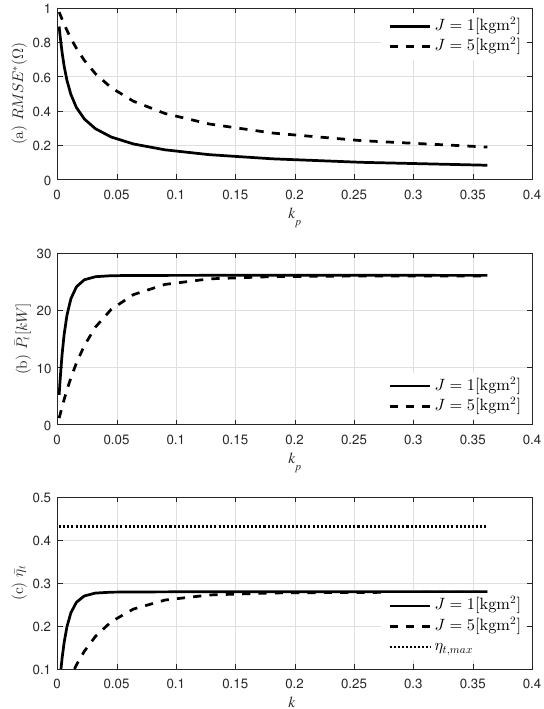
Figure 9. Results of the CAV controller with various k p under an equivalent irregular wave condition when Ω d = 250 rad/s: ( a ) relative root mean squared error of Ω ; ( b ) average power extraction from the turbine; ( c ) average turbine efficiency and its maximum value.